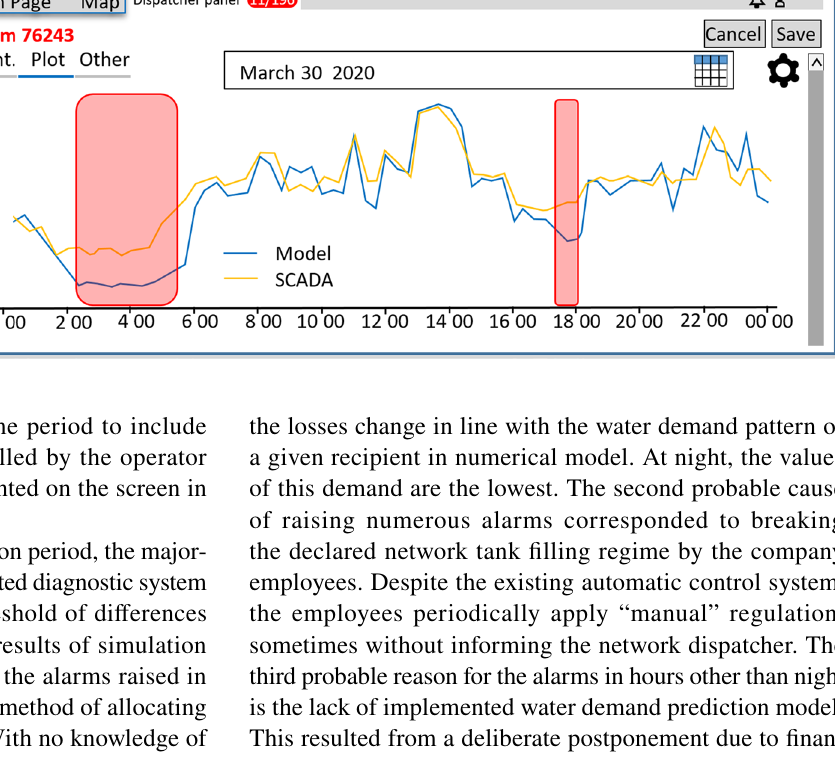
Fig. 7 List of alarms from 30th March 2020 screenshot Fig. 8 Details of an exemplary alarm